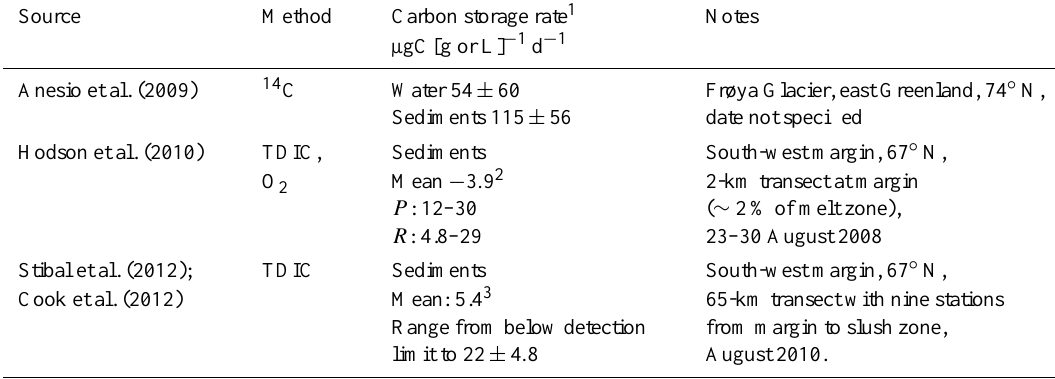
Table 1. Cryoconite hole carbon flux measurements in Greenland.